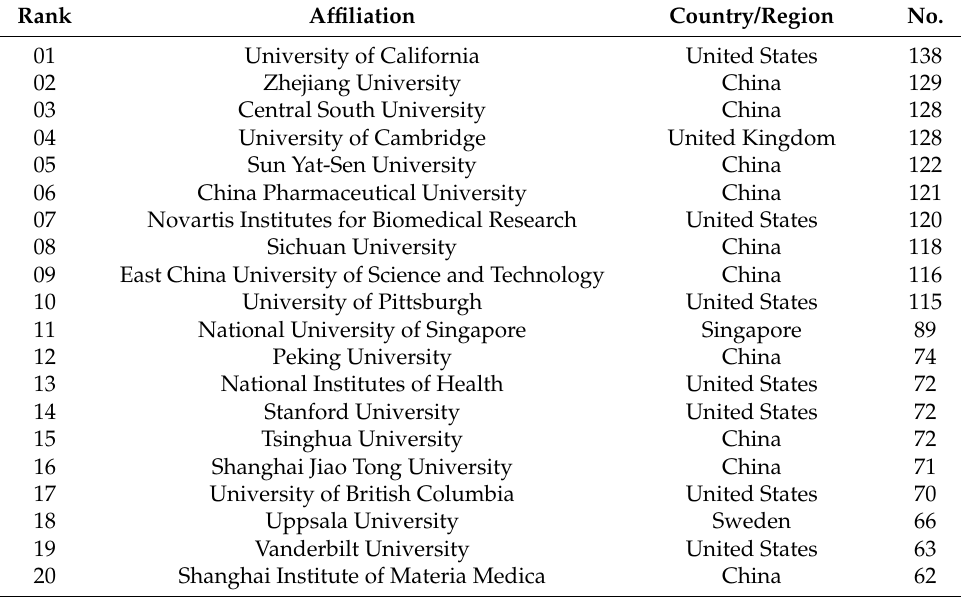
Table 7. Overview of the most productive